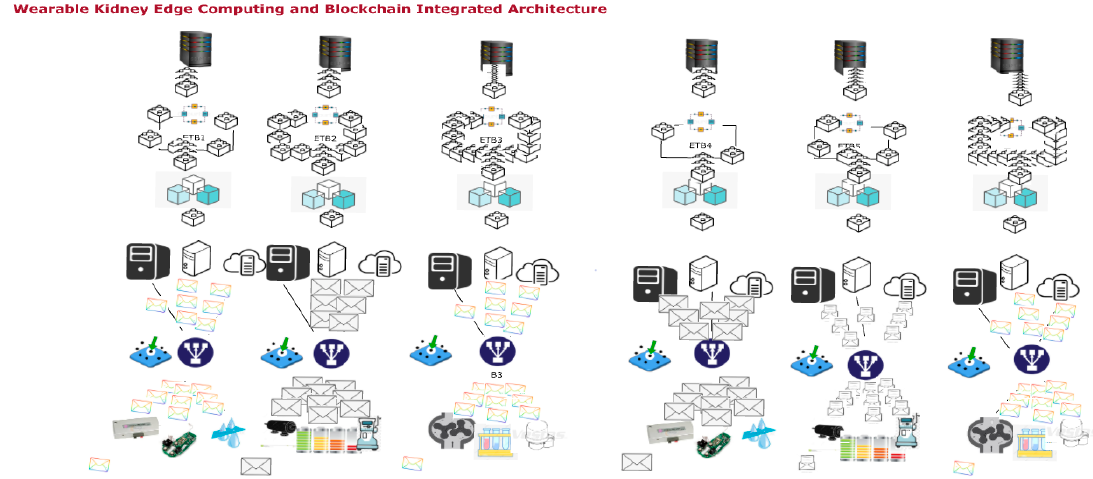
Figure 11. Proposed wearable kidney edge computing with IoT and blockchain technology in execution.